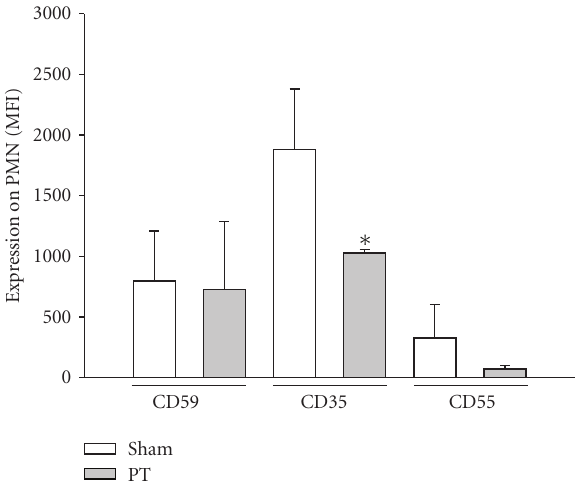
Figure 5: Complement regulatory response after trauma, CReg Expression (MFI) CD59, CD35 and CD55 on neutrophils (PMNs) in Sham- and PT rats 4 hrs after trauma. All data are presented as mean ± SD. ∗ P < 0 . 05. n = 6–10